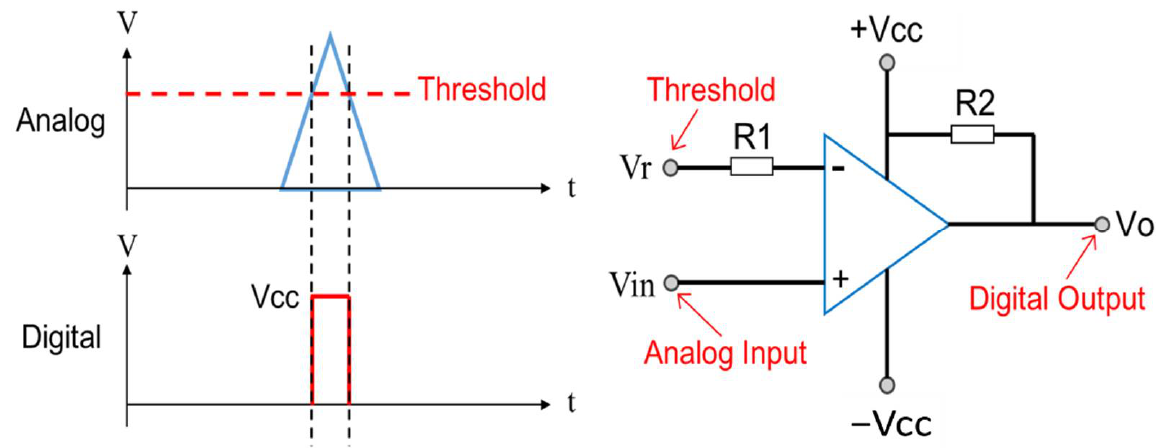
Figure 6. Schematic drawing of the comparator circuit.